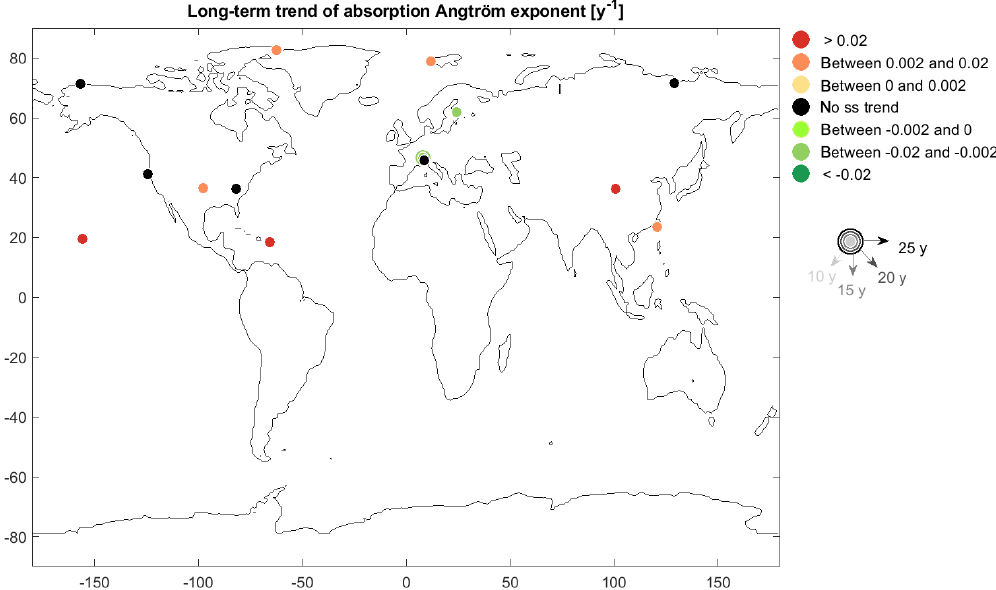
Figure 11. MK trend results for the absorption Ångström exponent. Other details same as Fig.